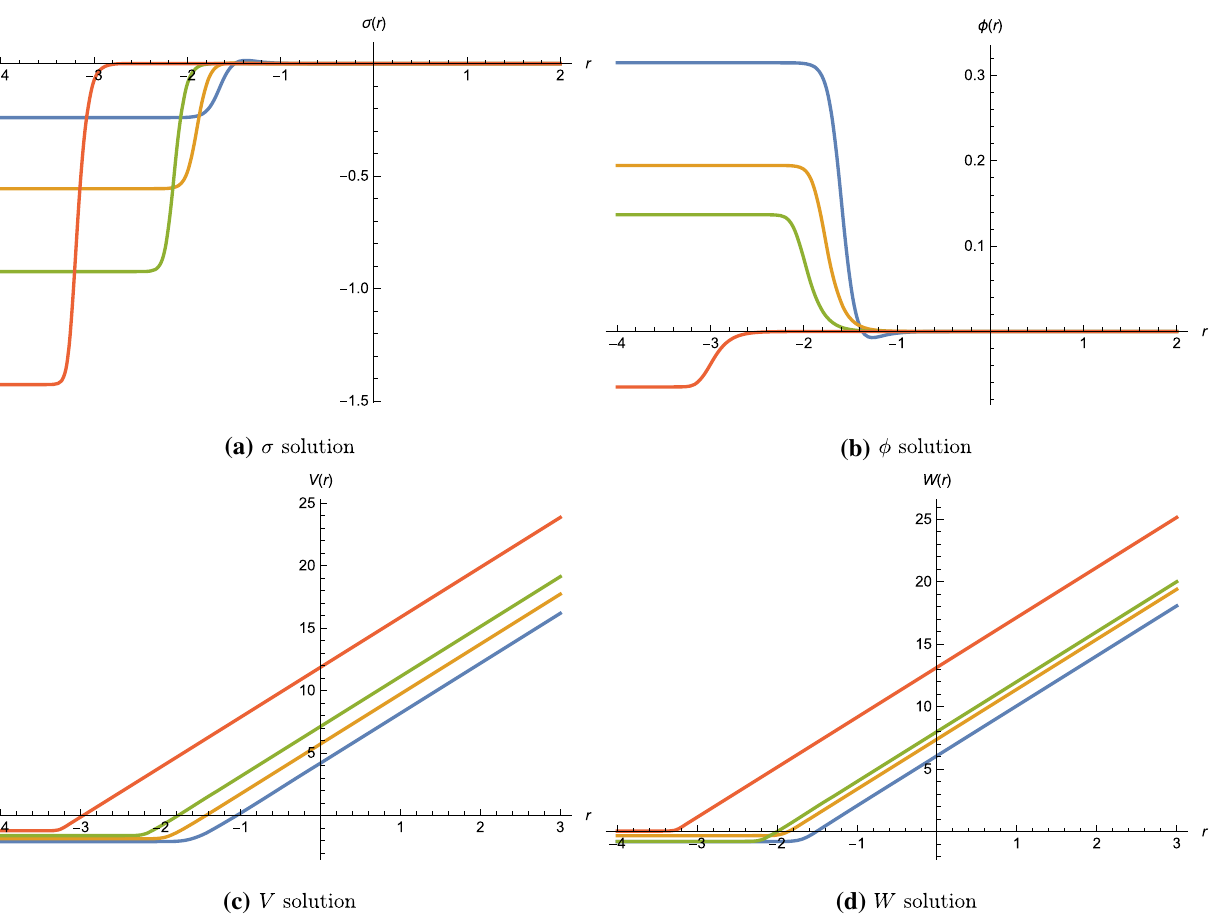
Fig. 4 RG flows from SO ( 4 ) N = ( 1 , 0 ) SCFT in six dimensions to two-dimensional N = ( 2 , 0 ) SCFTs with SO ( 2 ) × SO ( 2 ) symmetry dual to AdS 3 × H 2 × S 2 solutions for ( p 21 , p 22 ) = ( 1